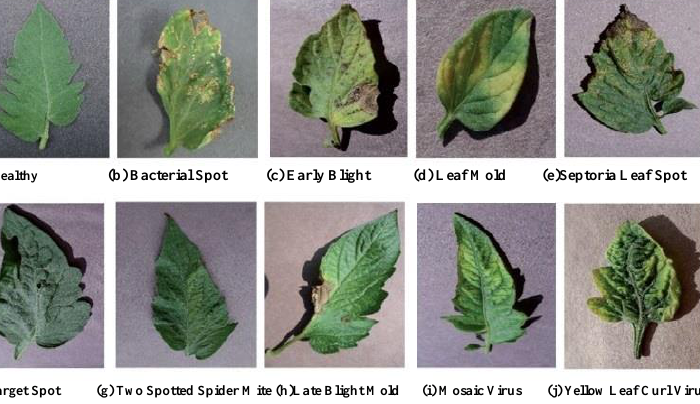
Figure 2. The sample images of the tomato leaf